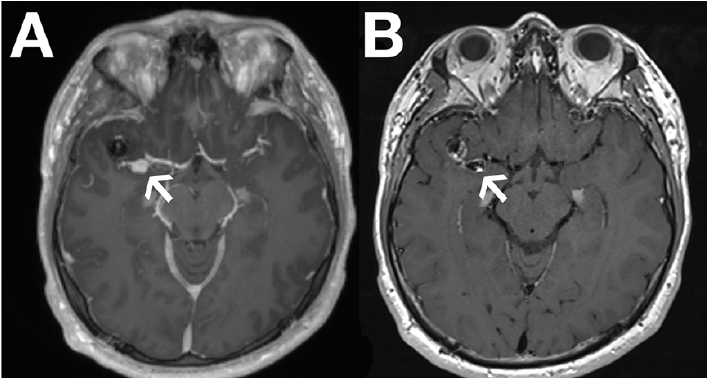
Figure 1. Images show gadolinium-enhanced T1 ( A ) and black blood images ( B ) of a dissection aneurysm following endovascular treatment with a flow diverter of a primary right medial cerebral artery aneurysm. The arrow shows contrast enhancement of the aneurysmal vessel wall on black blood imaging in ( B ), which cannot be seen on the conventional gadolinium-enhanced T1 image in ( A ). The finding indicates an unstable aneurysm.